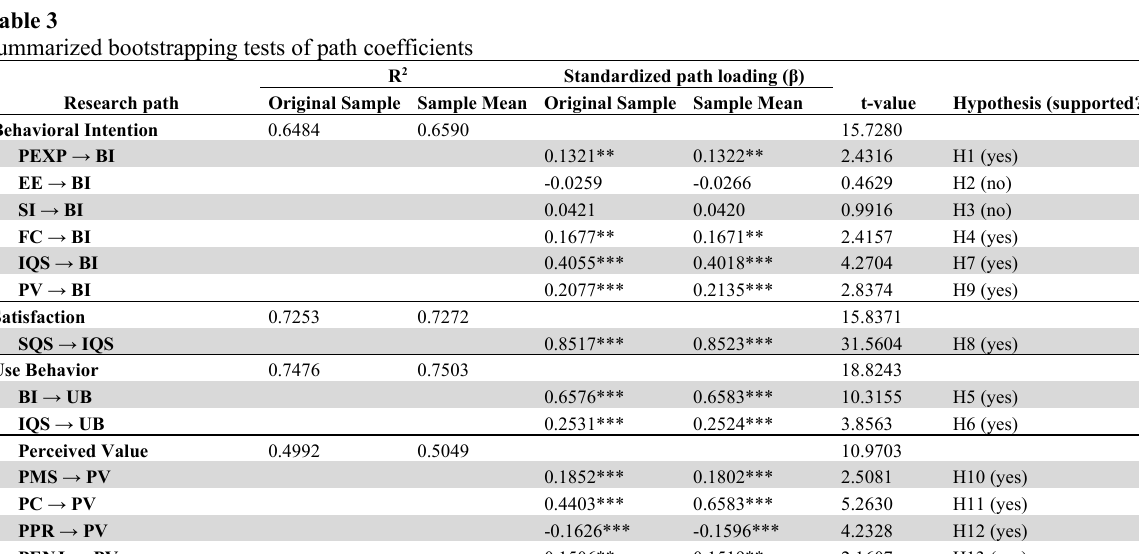
Fig. 3. Structural model